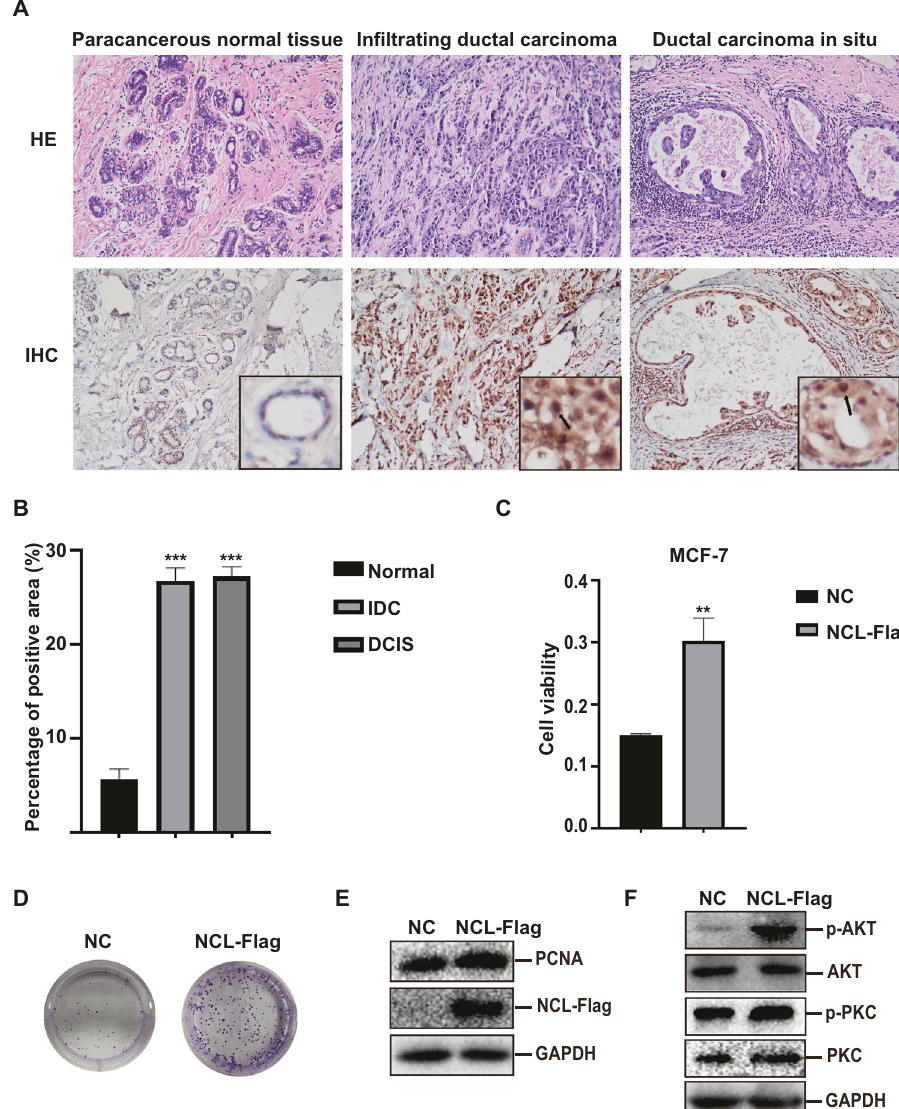
Fig. 2 NCL expression is associated with breast cancer progression. A H&E staining of breast cancer tissue and immunohistochemical staining using rabbit anti-human NCL antibody, and representative images of NCL expression in normal breast, IDC and DCIS. Magni fi cation is 400X. The enlarged image is shown in the lower right corner. B Quantitative analysis of NCL expression in breast tissue. The immunostaining of NCL was quanti fi ed based on tissue staining intensity and positive percentage. *** P < 0.001. C MTT assay assessed the viability of MCF-7 cells with stable expression of NCL. ** P < 0.01. D Colony formation assay determined the colony forming ability of MCF-7 cells with stable expression of NCL. E Western blotting analysis the expression of PCNA in NCL overexpression MCF-7 cells. F As in E , Western blotting analysis the expression of AKT, p-AKT, PKC and p-PKC NCL, NCL- Δ NT (284 – 710) and NCL-CT (630 – 710) exhibited inter- immobilized to the streptavidin-conjugated beads. The bound action with Orai1 (Fig. 3D, lane 1,4, 5, left panel). Unexpectedly, proteins were analyzed by SDS-PAGE and coomassie staining, NCL-NT (1 – 283) binding with Orai1 was also observed (Fig. 3D, which showed an obvious GST-NCL protein precipitated by Orai1- lane 2, left panel). The whole cell lysates and bound peptides on NT (Fig. 3B, lane 4), whereas no precipitation of GST was observed the beads were revealed by western blotting and Coomassie (lane 3) and no binding was observed for beads alone (lane 5,6). staining (Fig. 3D, middle and right panels). Next, we tested the co- Next, we mapped the domain of NCL responsible for interaction localization of NCL fragments with Orai1. MCF-7 cells were co- with Orai1-NT, whereas the central domain (284 – 629) of NCL was transfected with GFP-Orai1 and Flag-NCL fragment plasmids, then also dif fi cult to purify. We observed that the puri fi ed NCL-CT treated with or without TG, a blocker of sarcoendoplasmic fragment (630 – 710) was pulled down by the Orai1-NT peptide reticulum calcium ATPase (SERCA) pump to induce SOCE, followed (Fig. 3C, lane 4). To further con fi rm the interaction domain, Flag- by immuno fl uorescence staining with anti-Flag antibody (red tagged full- length NCL and NCL fragments were expressed in fl uorescence). Expression of GFP-Orai1 exhibited its localization in MCF-7 cells. Cell lysate was incubated with biotin-Orai1-NT the plasma membrane and NCL (1 – 283) mainly localized in the peptide followed by pulling-down with streptavidin beads and nucleoplasm. No obvious Orai1/NCL (1 – 283) co-localization was western blotting with anti-Flag antibody. Consistently, full-length